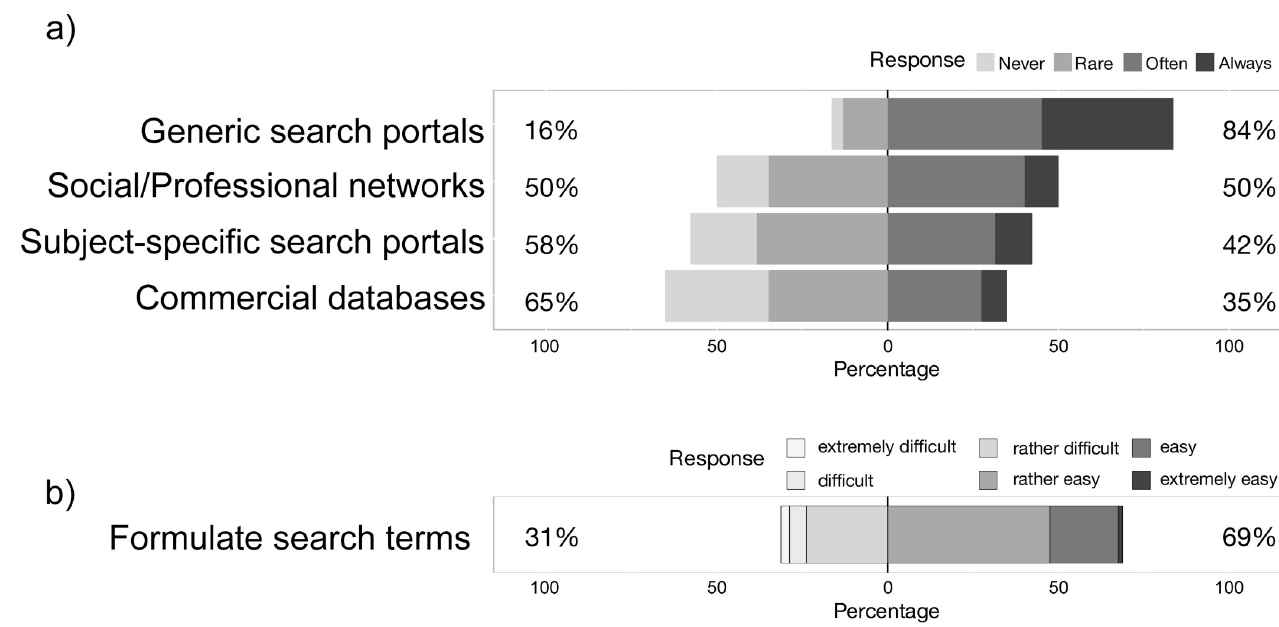
Fig 3. Searching for research data. a) How often do data providers and users use different available search tools to search for relevant data and literature publications (N = 149–153; Q37)? b) Respondents’ assessment of how they rate the formulation of clear and sensitive search terms when searching for relevant data and articles, especially in interdisciplinary context (N = 160; Q38).